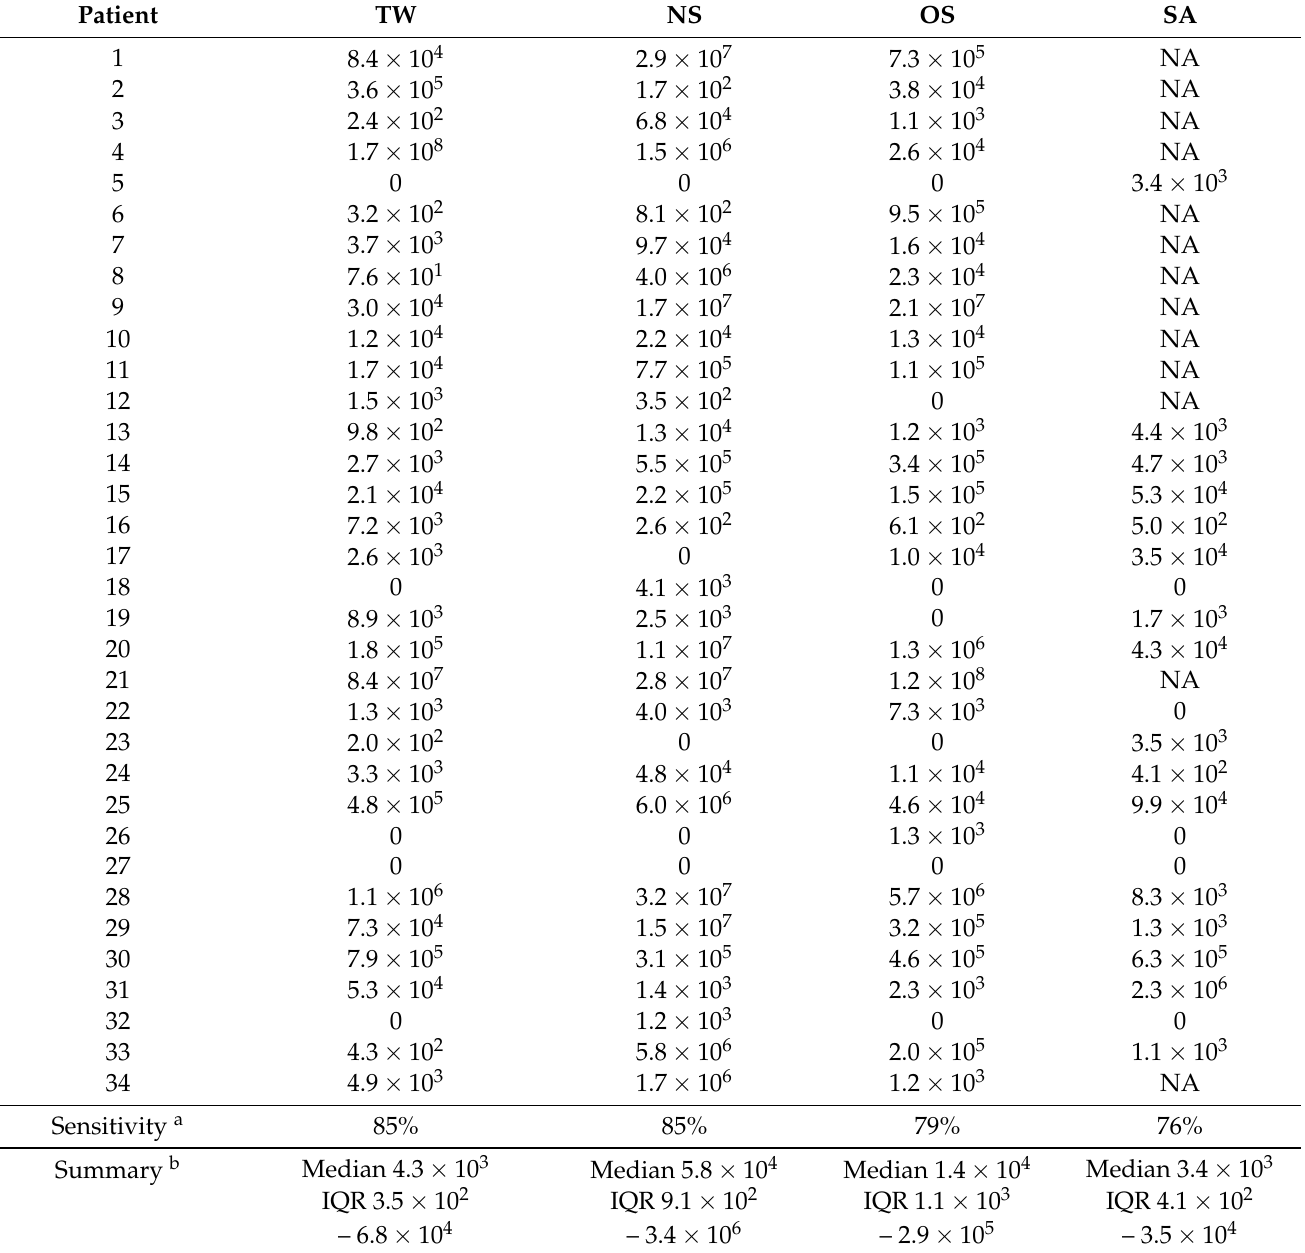
Table 2. Quantitative Results (SARS-CoV-2 RNA copies per